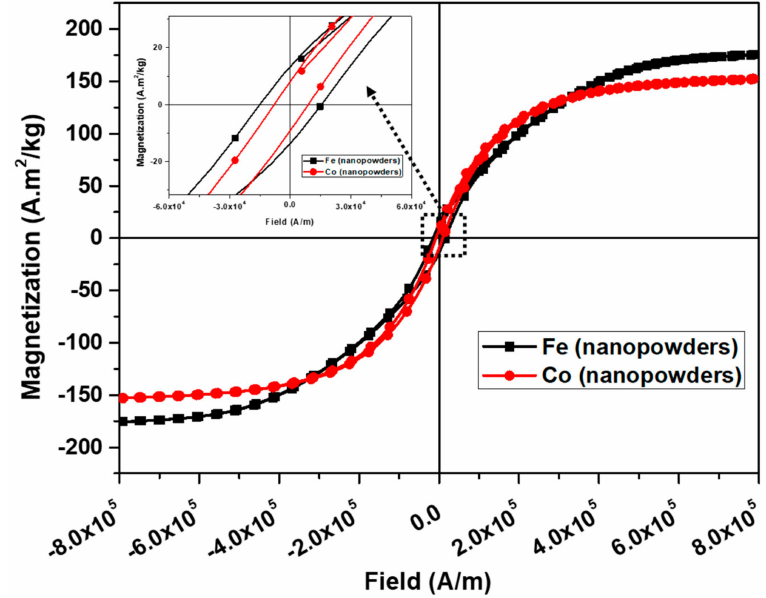
Figure 9. Hysteresis curves of as-received Fe and Co